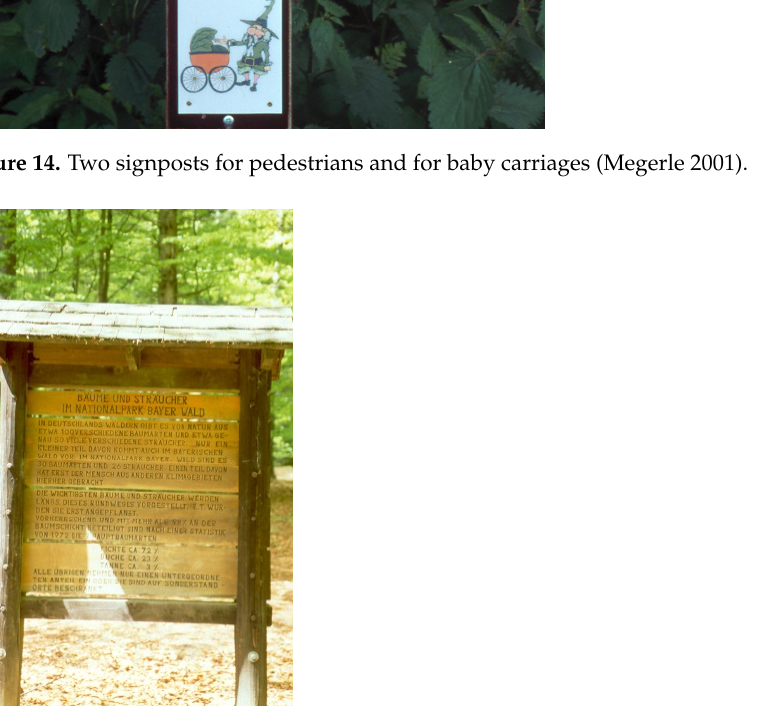
Figure 15. Wooden board in the Bavarian Forest National Park (Germany) with writing difficult to read (Megerle 2000).